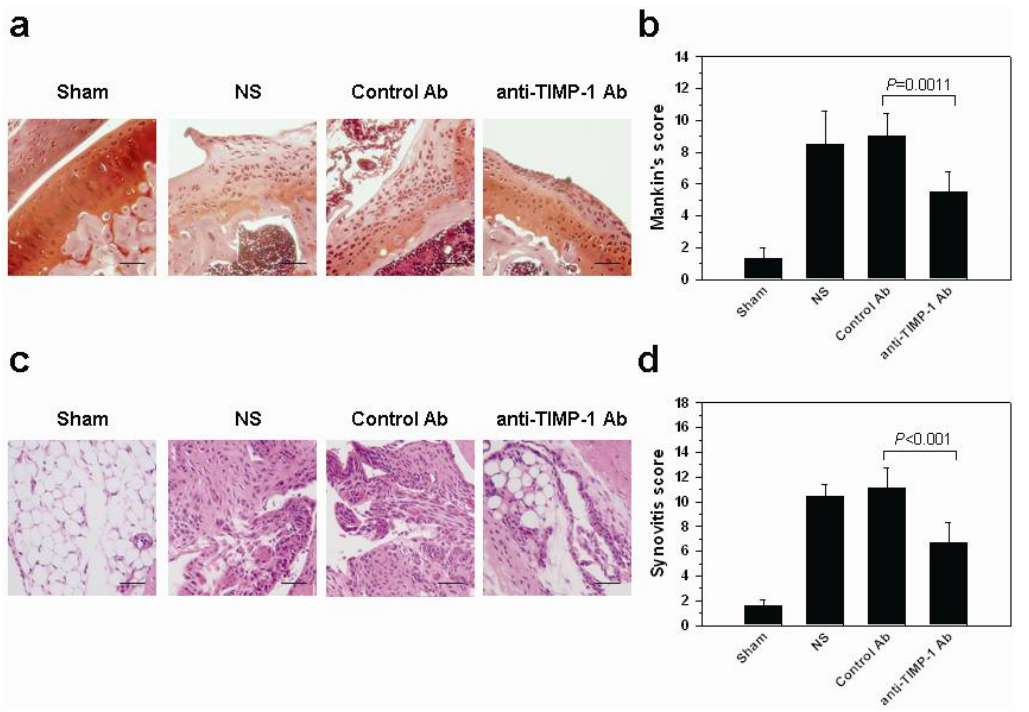
Figure 7. Histological analysis in the knee joints of TIMP-1 neutralization antibody-treated mice ( n = 5 per group). Cartilages from the medial femoral condyle are shown. ( a ) Representative sections of cartilage whose scores were closest to the mean in each group were shown (Safranin-O/fast green stain; 200× magnification, scale bar = 50 µm). The specimens from mice treated with NS and control antibody showed remarkably specimens had an irregular superficial layer of cartilage. The surface layer of cartilage in